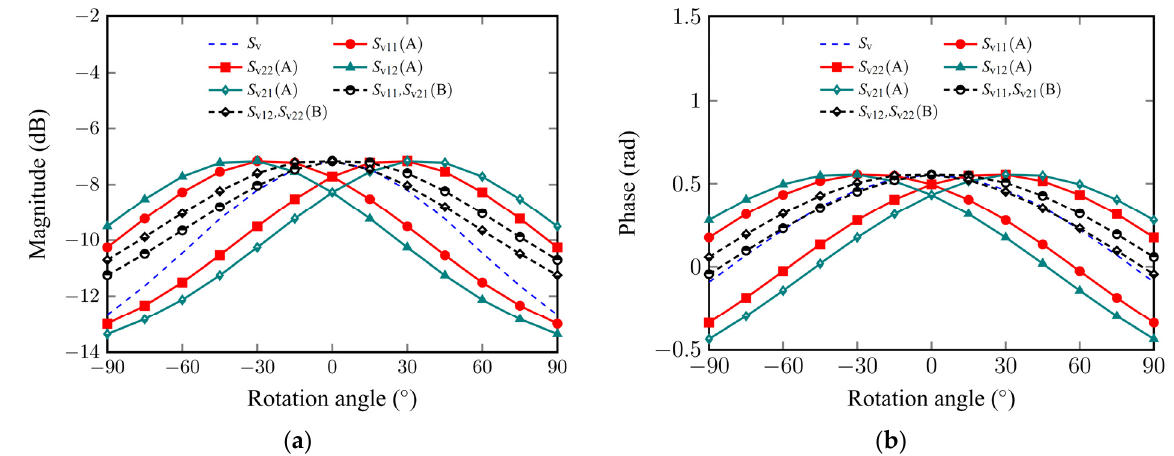
Figure 6. Variation of the transfer responses for virtual plants with human head rotation: ( a ) magnitude; ( b ) phase.